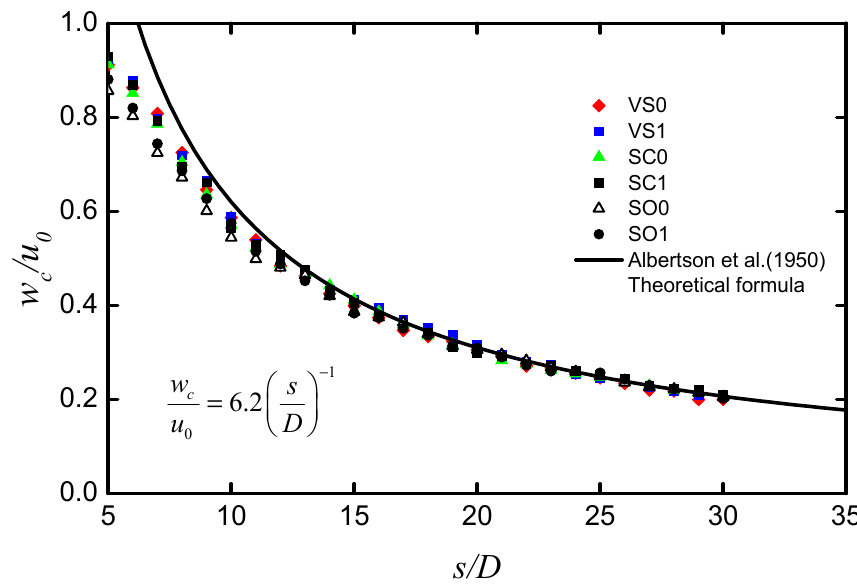
Figure 4. Values of w c / u 0 along the jet mean axis.